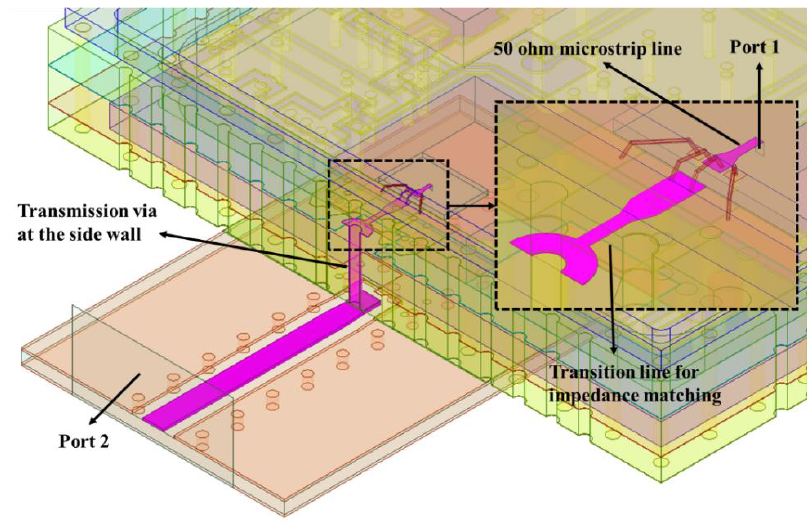
Figure 3. 3D electromagnetic simulation of key microwave transmission structure of the SIP.